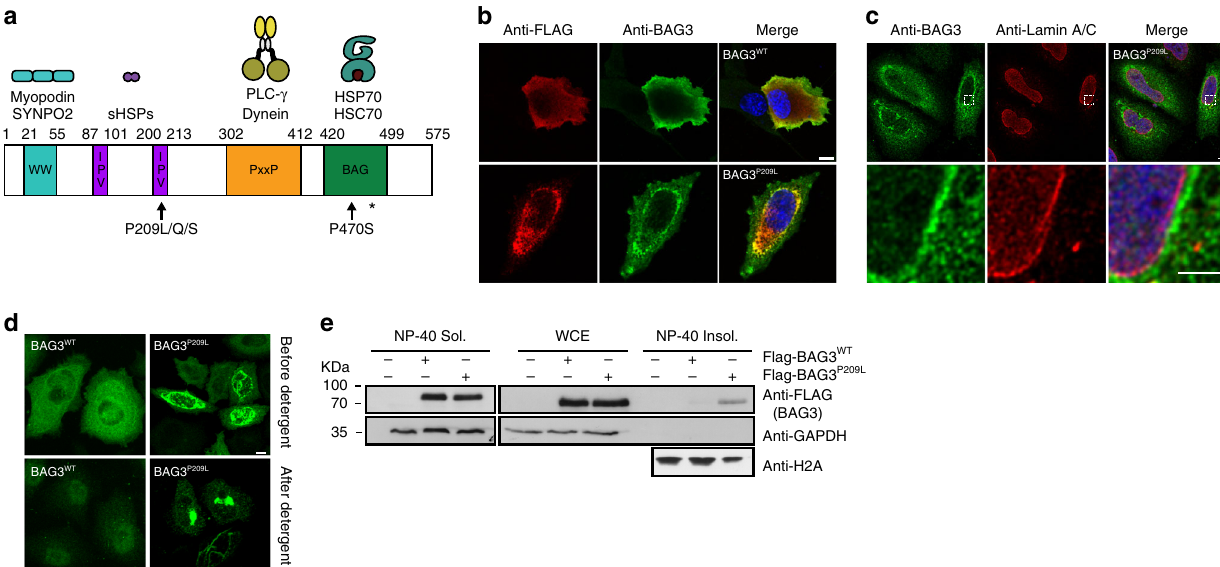
Fig. 1 Cytoplasmic protein aggregation by BAG3P 209L . a Schematic representation of BAG3 depicting the WW domain, the IPV motifs, the PxxP domain and the BAG domain. The disease-causing mutations P209L, P209Q, and P209S, and p470S are indicated with an arrow. The Hsp70-interaction disrupting mutation R480A is indicated with an *. b Immuno fl uorescence pictures of myoblast expressing FLAG-BAG3 WT or FLAG-BAG3 P209L , using BAG3 (green) or FLAG (red) antibodies. DAPI staining is shown in blue. Scale bar = 5 μ m. c Immuno fl uorescence pictures of HeLa cells expressing FLAG-BAG3 P209L using antibodies against BAG3 (green) and Lamin A/C (red). DAPI staining is shown in blue. Scale bar = 5 μ m. d Immuno fl uorescence pictures of FLAG- BAG3 WT and FLAG-BAG3 P209L expressing HeLa cells using BAG3 antibody (green) before and after detergent treatment prior to fi xation. Scale bar = 5 μ m. e Whole cell extracts (WCE) and NP-40 soluble and insoluble fractions of HEK293 cells expressing indicated FLAG-BAG3 variants. Western blot against the indicated antibodies is shown. Source data are provided as a Source data fi